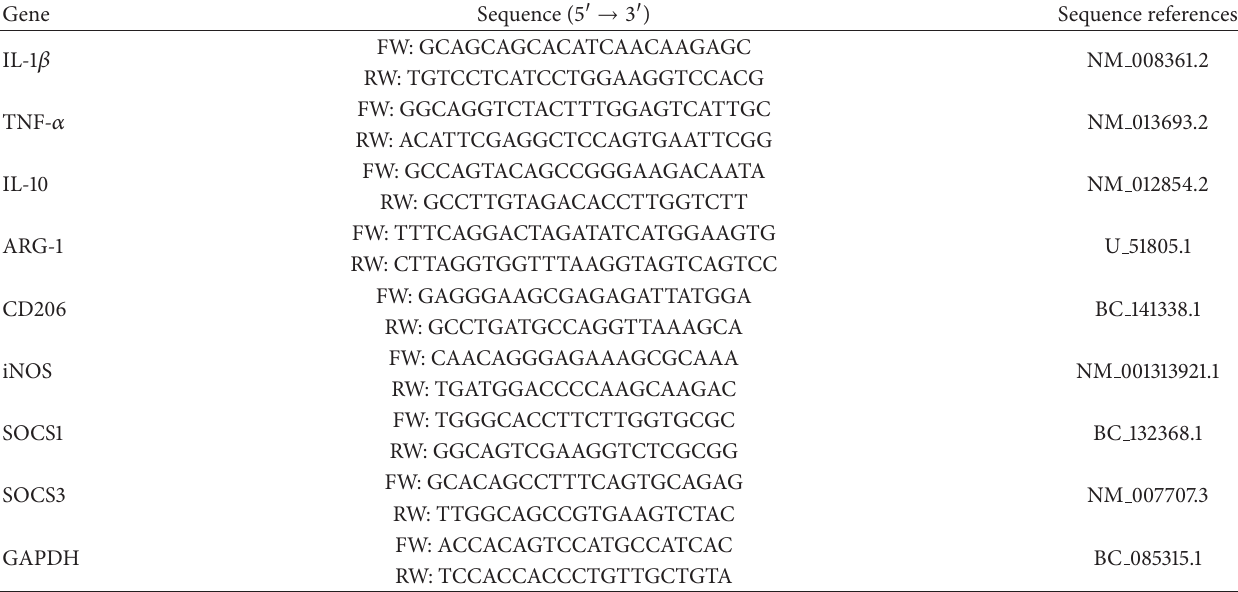
Table 1: DNA sequences of primers used in PCR reactions.